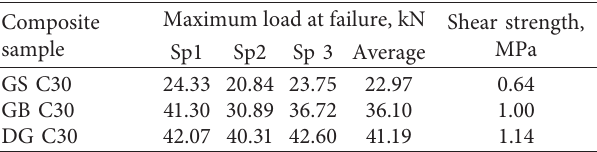
Figure 3: Failure characteristics of the composite samples after the shear test: (a) GS C30, (b) GB C30, and (c) DG C30. Table 3: A summary of the shear load at failure and shear strength of the plate-concrete interfaces for samples with different cement plates.